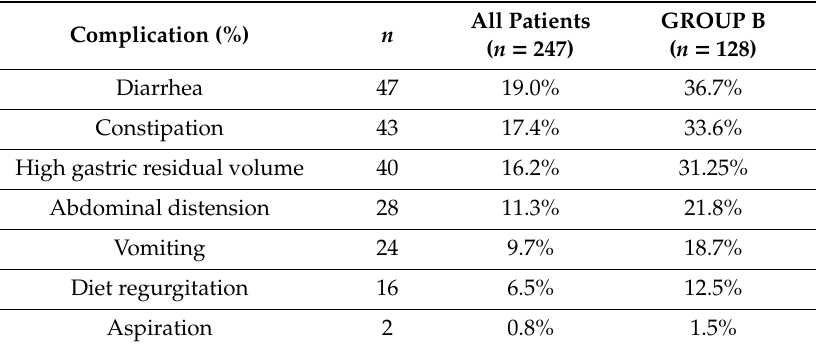
Table 2. Rate of gastrointestinal complications.